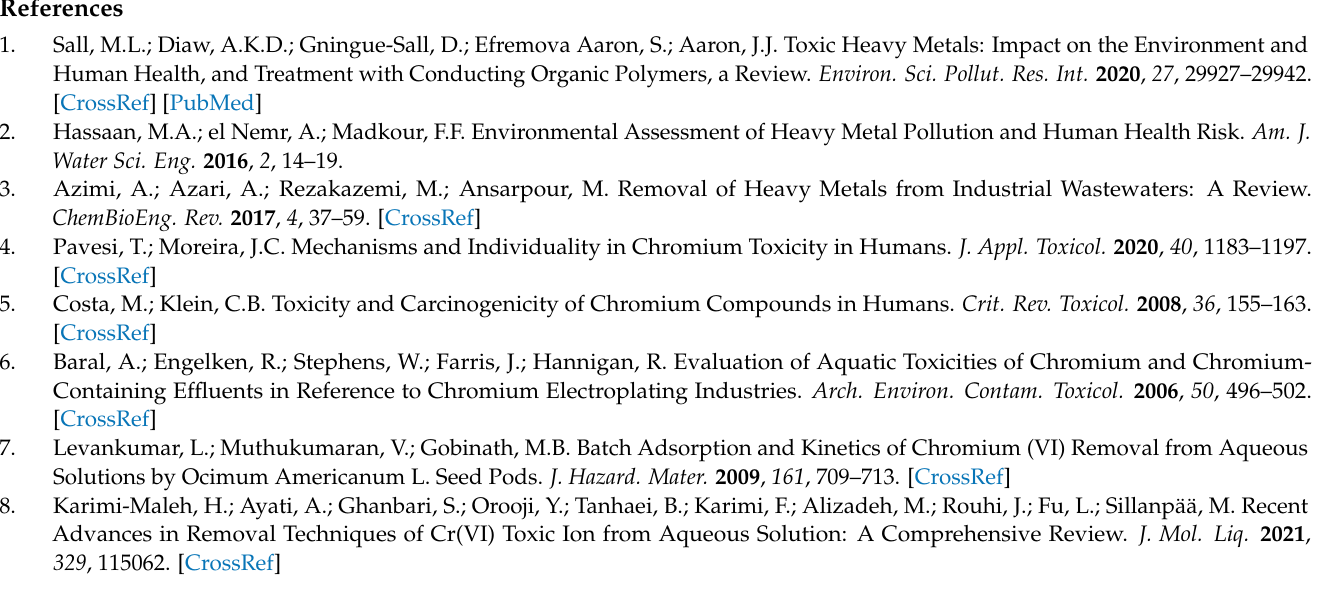
for the GCN_ b , GCN, P-GCN and Ni 2 P/P-GCN; Figure S4: UV-vis/NIR absorption spectra of the GCN_ b , GCN, Ni 2 P/P-GCN and 15-Ni 2 P/GCN_ b ; Figure S5: UV-vis/NIR absorption spectrum of the Ni 2 P particles; Figure S6: XRD pattern of the 15-Ni 2 P/GCN_ b ; Figure S7: N 2 adsorption-desorption isotherms and NLDFT pore-size distribution for the 15-Ni 2 P/GCN_ b ; Figure S8: Concentration- dependent photocatalytic Cr(VI) reduction activity of 15-Ni 2 P/P-GCN; Figure S9: Effect of the solution pH on the photocatalytic Cr(VI) reduction performance; Figure S10: XRD pattern of the catalysts; Table S2: Textural properties and energy band gap of GCN_ b , GCN, P-GCN and Ni 2 P/P- GCN; Table S3: Comparison of photocatalytic efficiency between 15-Ni 2 P/P-GCN and other reported g-C 3 N 4 -based catalysts [59–68]; Table S4: PL lifetime decay fitting results for the GCN_ b , GCN, P-GCN and 15-Ni 2